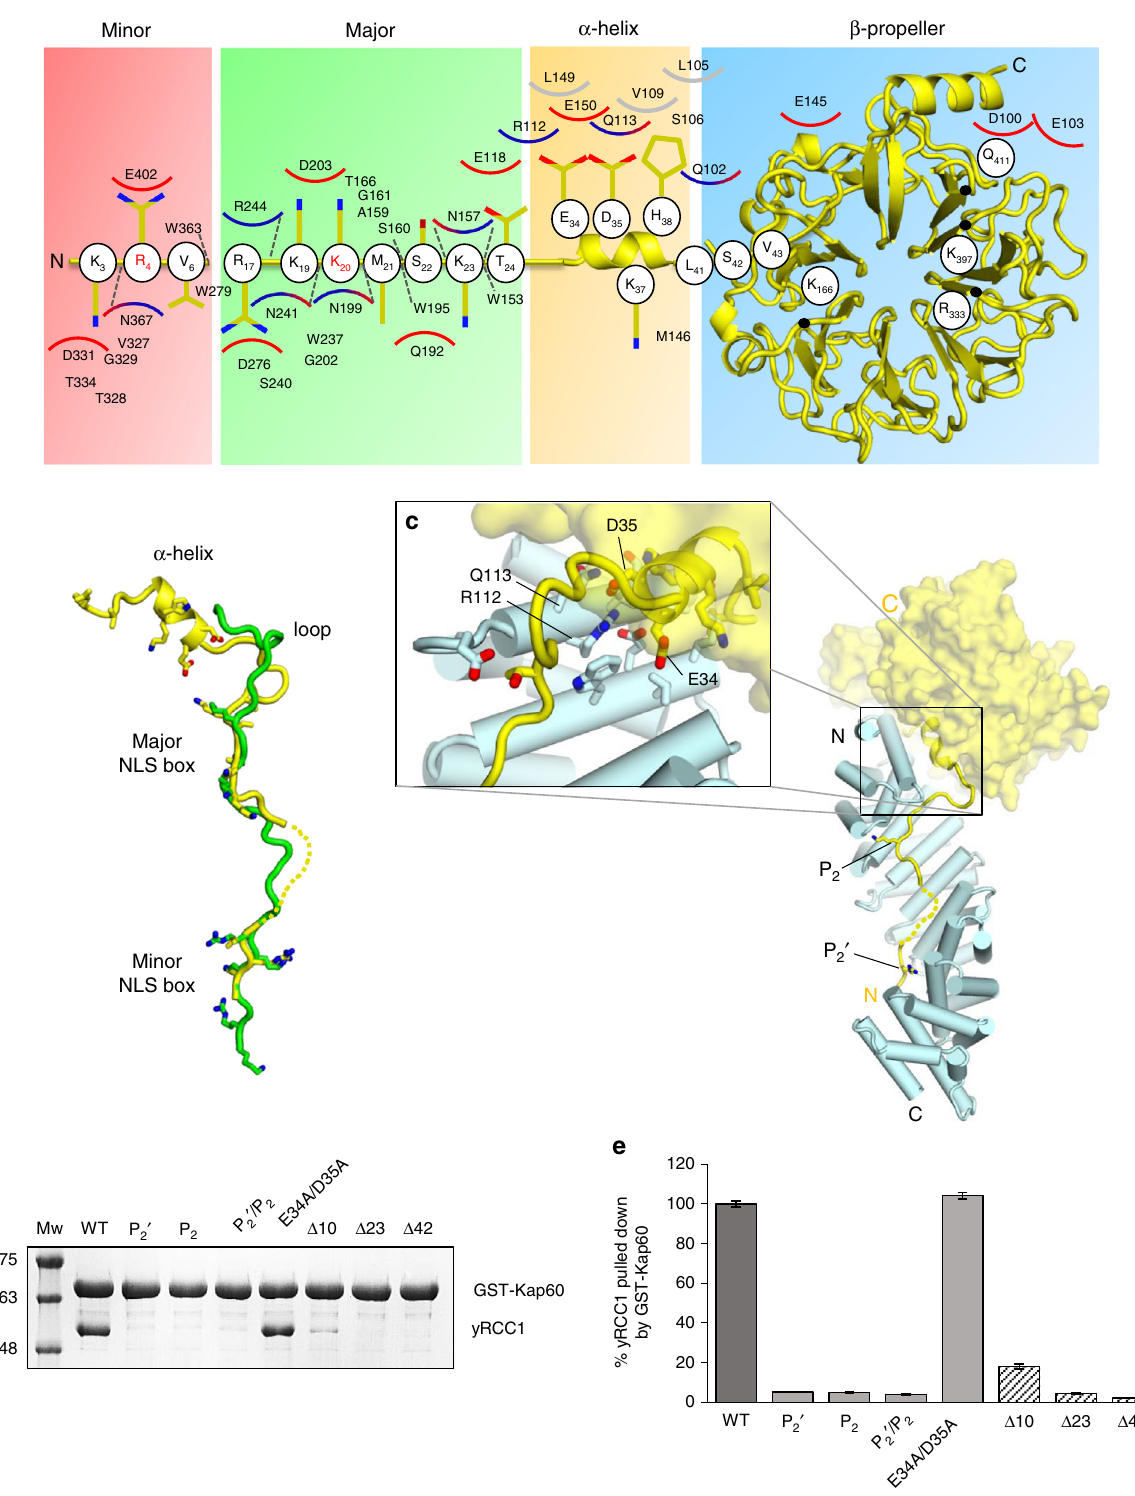
Fig. 7 Kap60:yRCC1 binding interface. a Schematic diagram of the interactions between the yRCC1 N-terminal tail and Kap60. R4 and K20 at positions P 2 ′ and P 2 , respectively, are shown as red letters. b Superimposition of the bipartite NLSs and C-terminal regions of yeast and human RCC1 colored in yellow and green , respectively. c Crystal structure of Kap60 ( light cyan ) bound to yRCC1 ( yellow ) illustrating contacts between the C-terminal α -helix and Kap60 Fig. 3c. e Pull-downs are shown as mean ± SD for three independent experiments. No interaction was observed between free yRCC1 and glutathione beads (Supplementary Fig.